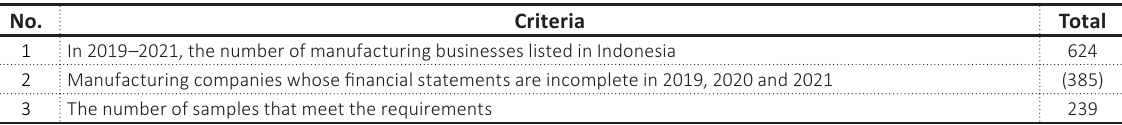
Table 1. Final research